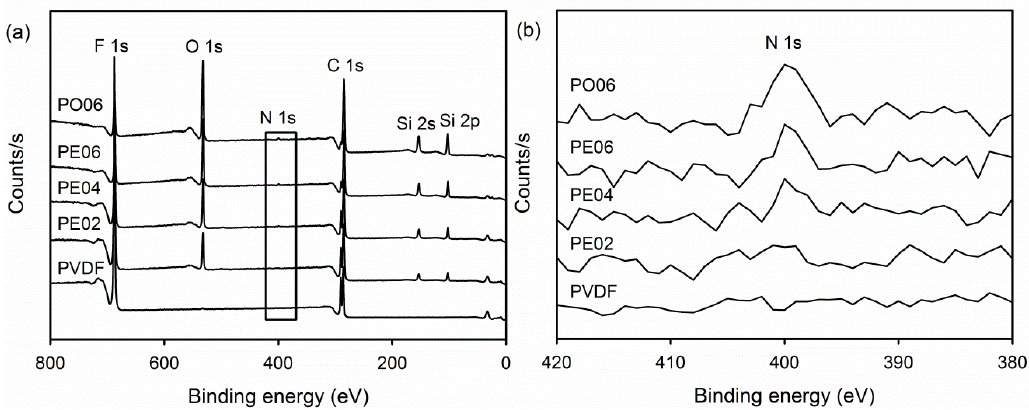
Figure 4. ( a ) X-ray photoelectron (XPS) spectra of the PVDF composite nanofibers and ( b ) the magnified XPS spectra of the areas in (a) marked by rectangle.